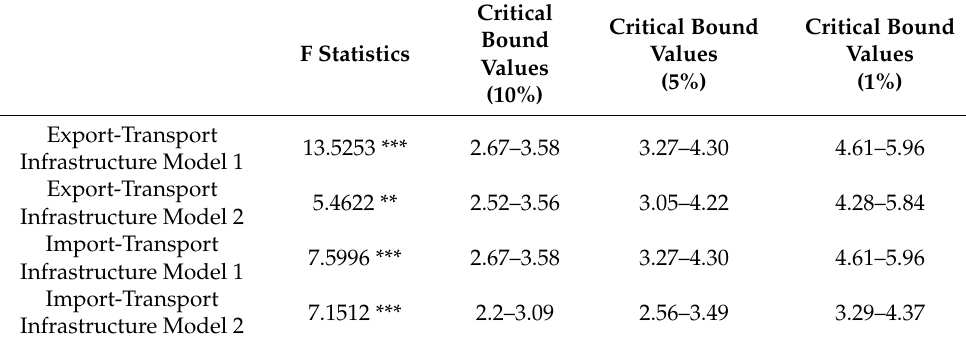
Table 4. Bounds test